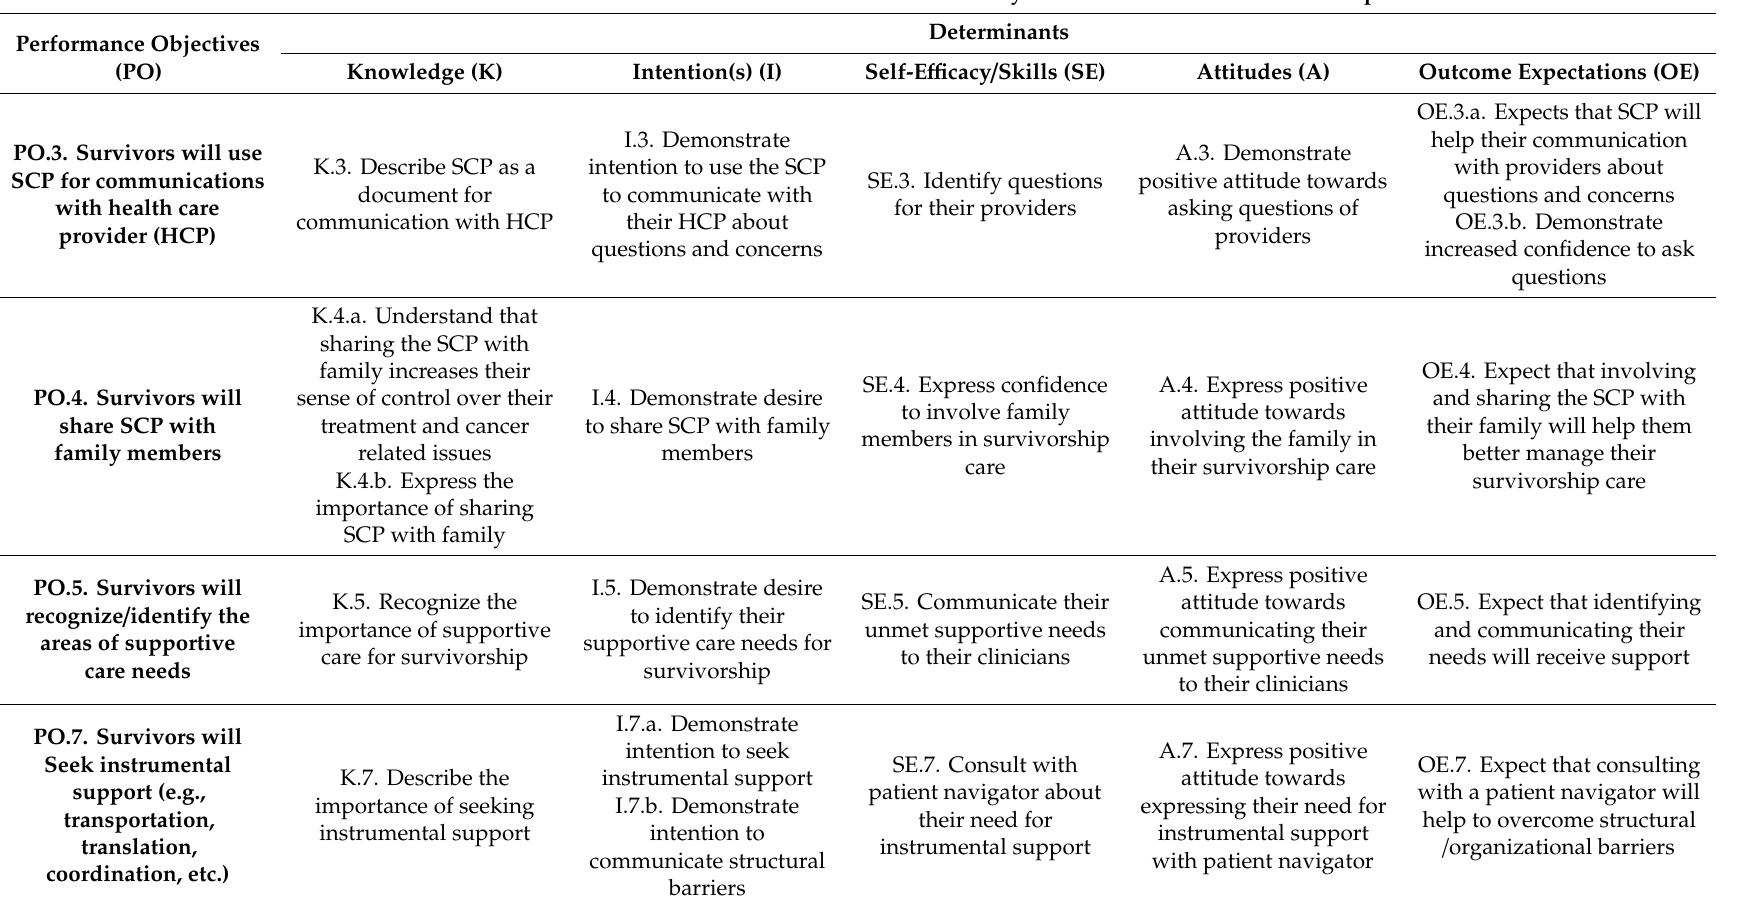
Table 3. Sample Cells from Matrix of Change